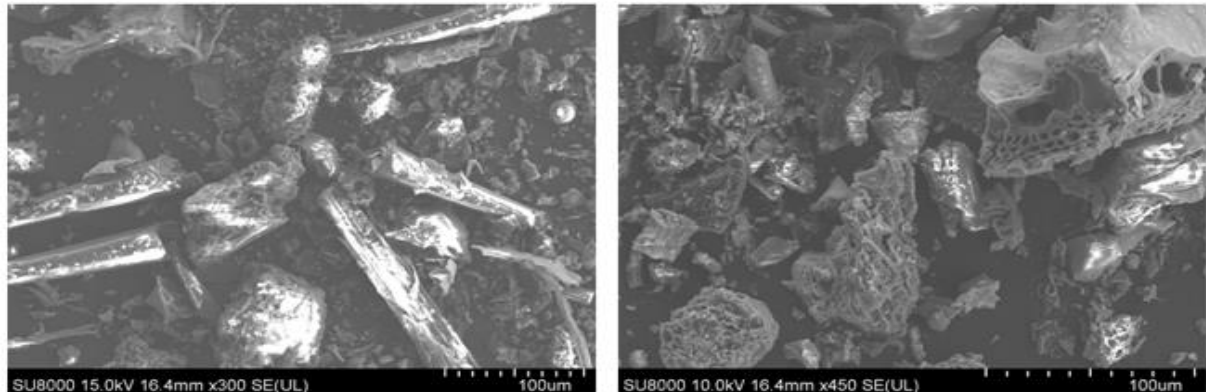
Fig. 1. SEM images of RH (a) and BC